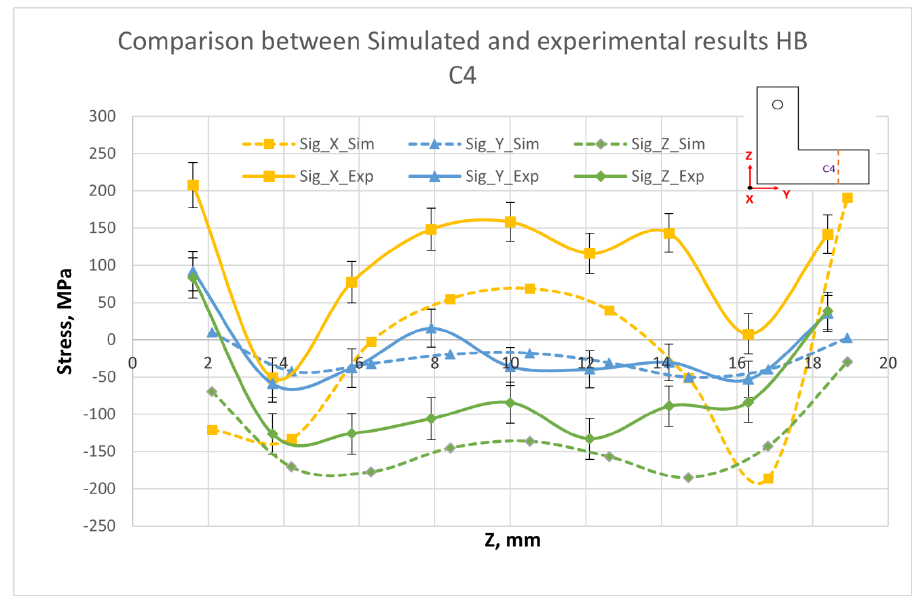
Figure 21. Comparison between experiment and simulation results for HB sample cross-section C4.